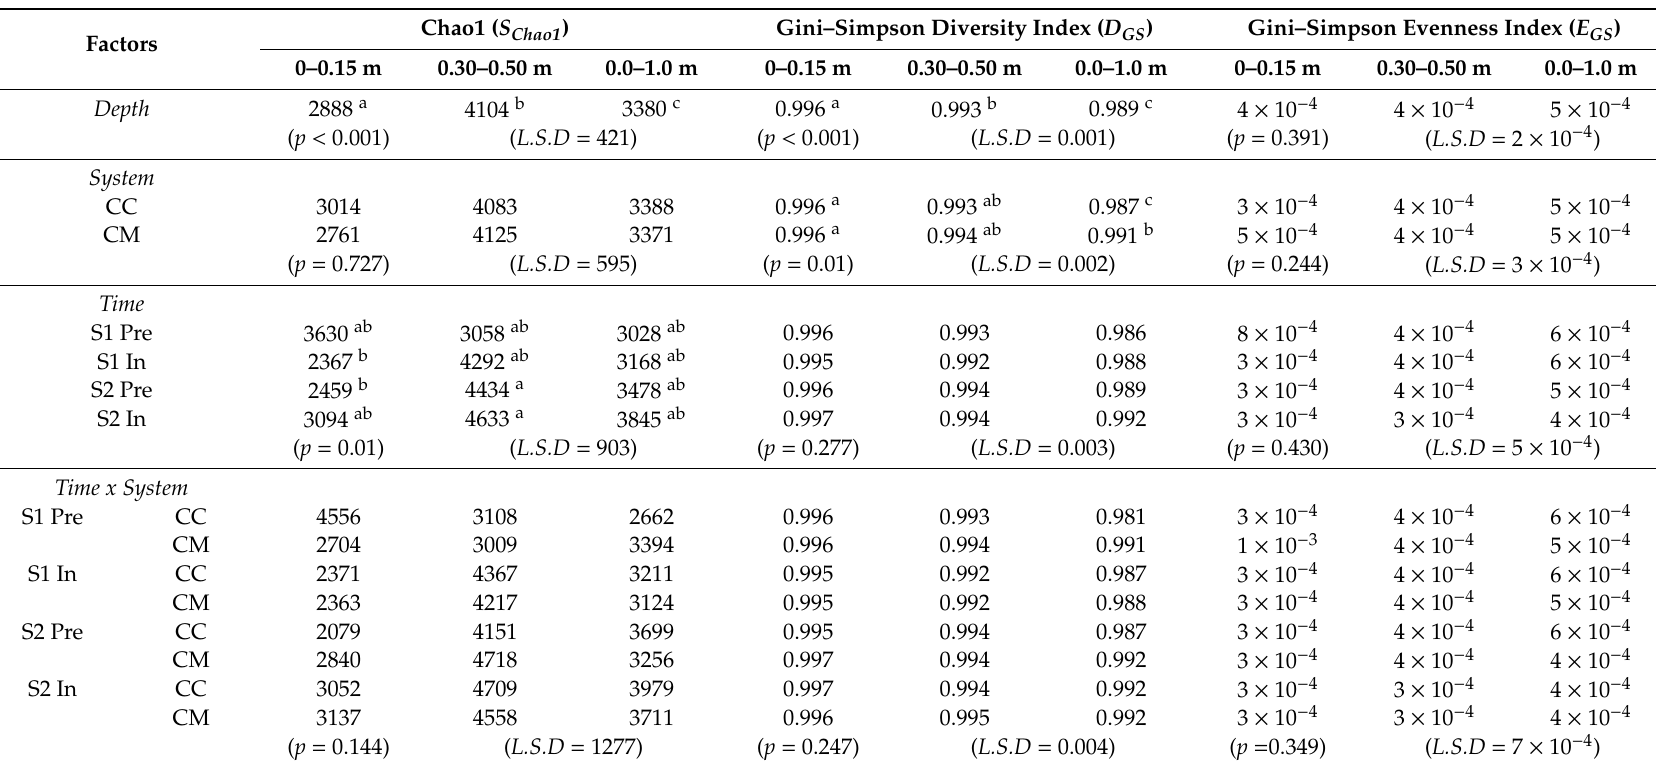
Table 2. Alpha-diversity of bacterial 16S OTUs down the soil profile as measured by the Chao1 species richness indicator ( S Chao1 ), the Gini–Simpson Diversity Index ( D GS ) and the Gini–Simpson Evenness Index ( E GS ) as influenced by system, sample time and sample time by depth. Lower case letters indicate significant di ff erences based on least significant values